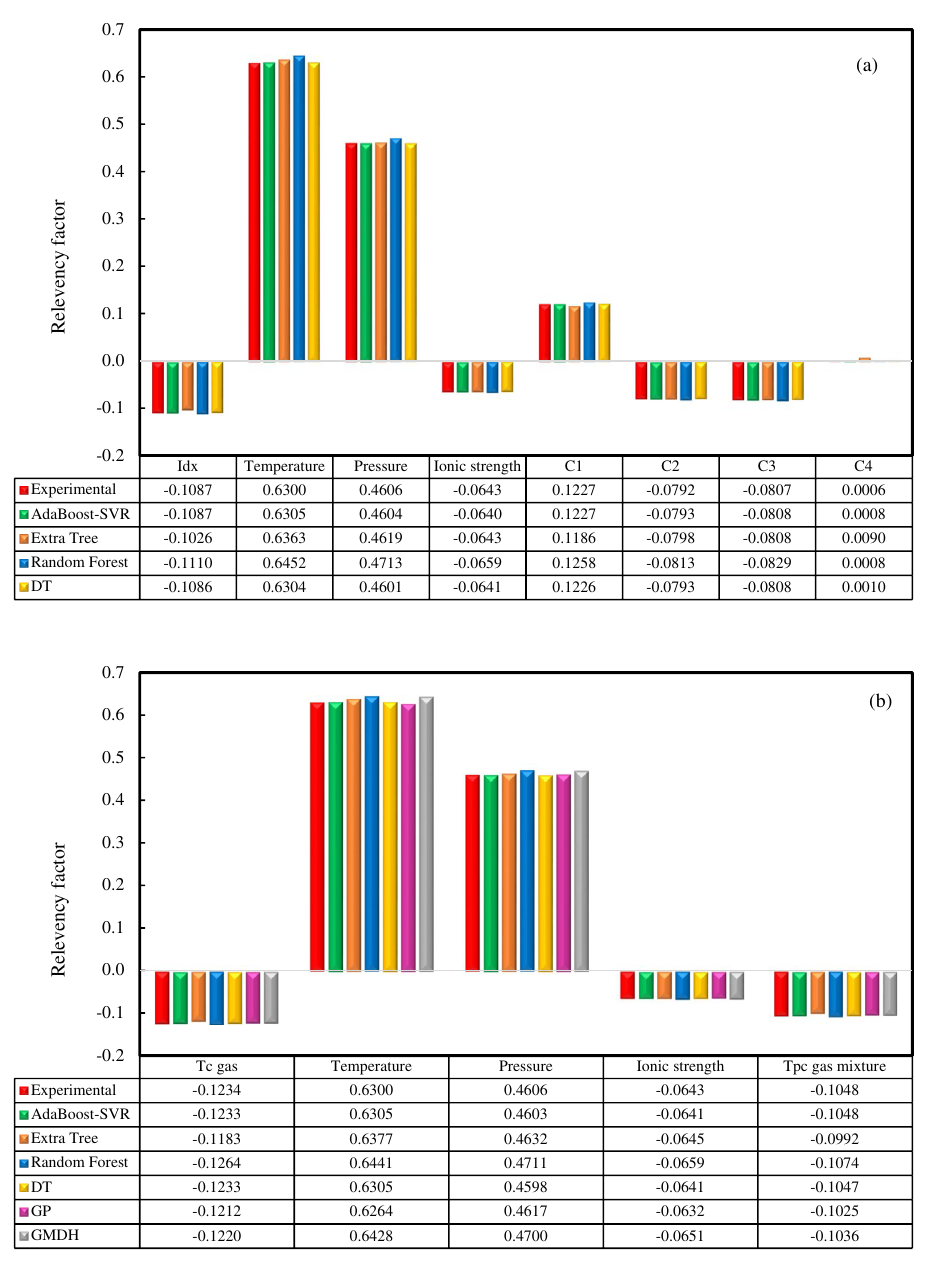
Figure 11. The impact of input variables on hydrocarbon gases solubility in water and aqueous electrolyte systems in the ( a ) first and ( b ) second modeling